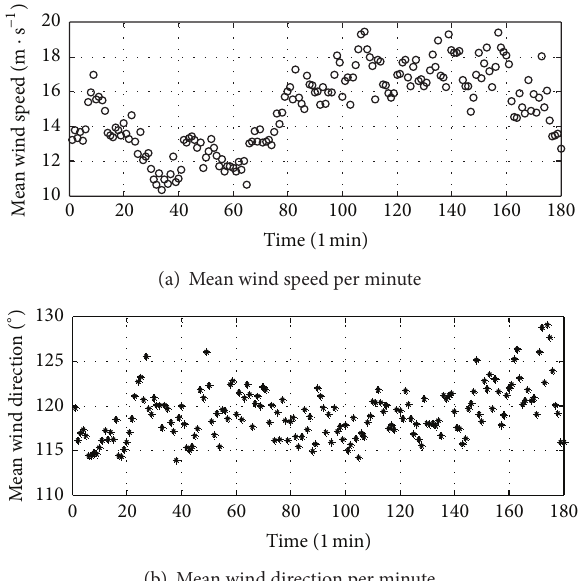
Figure 9: 10 min turbulence intensity of Typhoon Fung-Wong.